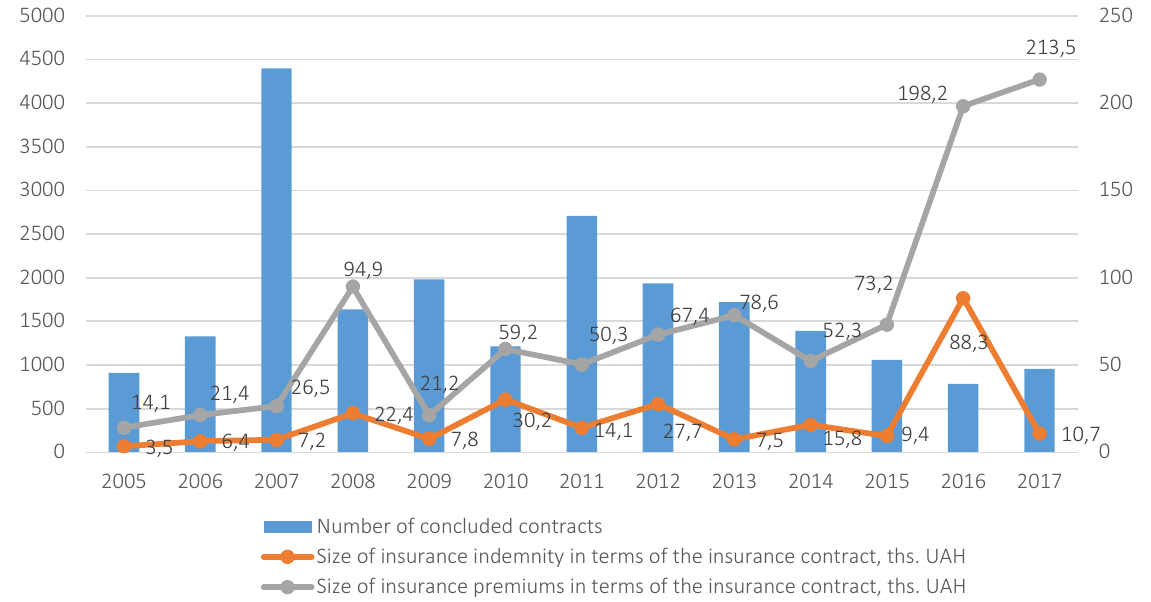
Figure 4. Trends in the market of Ukraine’s agricultural insurance services in